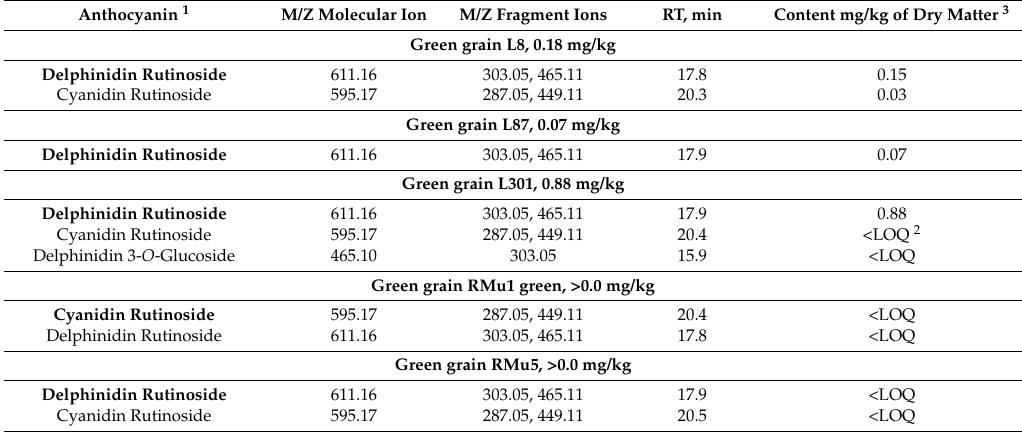
Table 1. Identification and tentative quantification of anthocyanin composition in rye